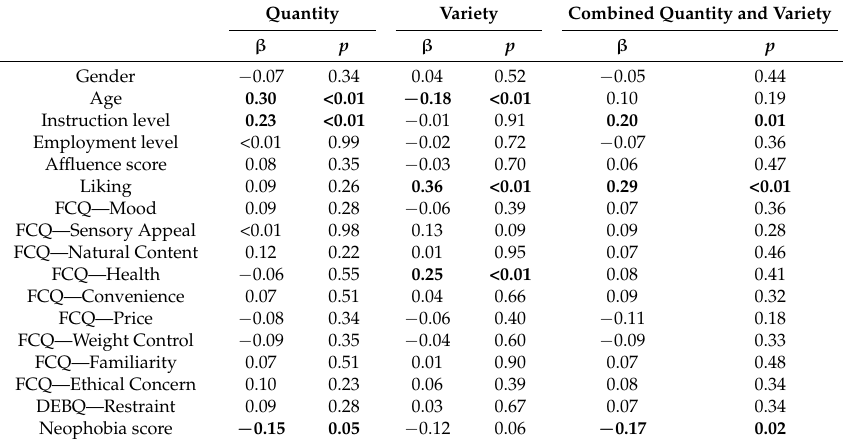
Table 4. Results of the regression analyses using demographic characteristics and all liking and attitude variables to predict quantity, variety and combined quantity and variety scores in French participants ( n = 187). Regression equations: Quantity: R = 0.46, R 2 = 0.21, adjusted R 2 = 0.13, F (17,186) = 2.60, p < 0.01; Variety: R = 0.67, R 2 = 0.45, adjusted R 2 = 0.40, F (17,186) = 8.27, p < 0.01; Combined quantity and variety: R = 0.46, R 2 = 0.21, adjusted R 2 = 0.13, F (17,186) = 2.60, p < 0.01.